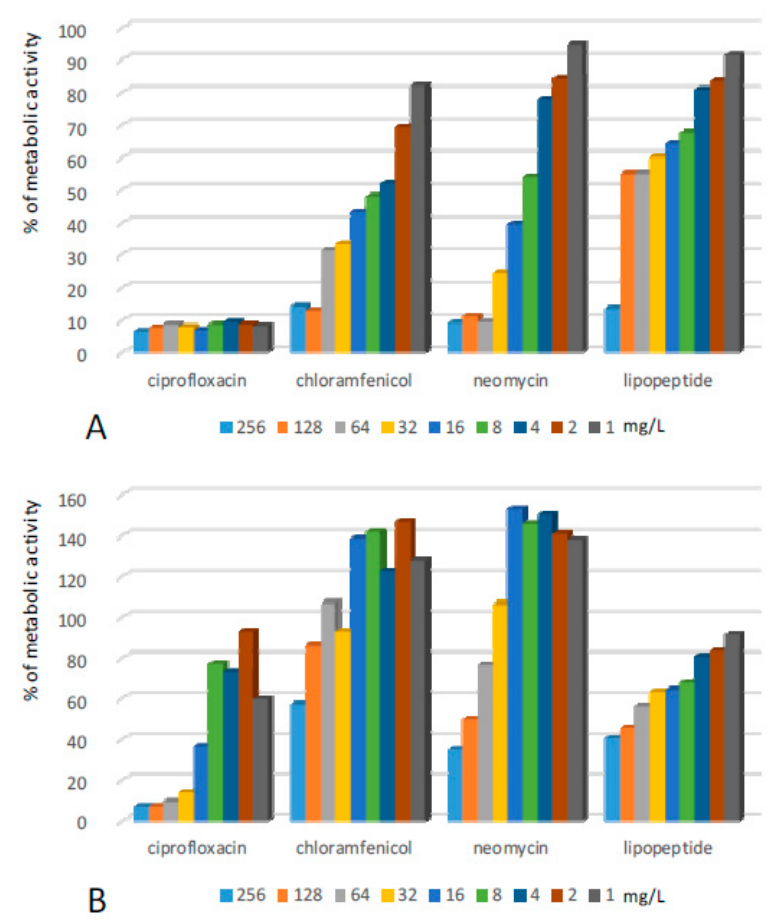
Figure 5. Activity of the lipopeptide and conventional antimicrobials applied at concentrations of 1–256 mg/L against PA biofilms formed on polystyrene ( A ) results read after 24 h exposure to compounds; and ( B ) results read after the withdrawal of compounds and additional 24 h of incubation in MHB II). The results are presented as the percentage of metabolic activity in comparison to positive (100%) and negative (0%) controls; RSD ≤ 15%.